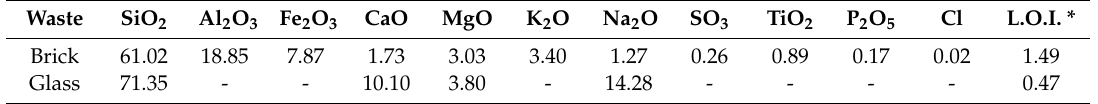
Table 2. Chemical composition of the CDW precursors (% w/w).